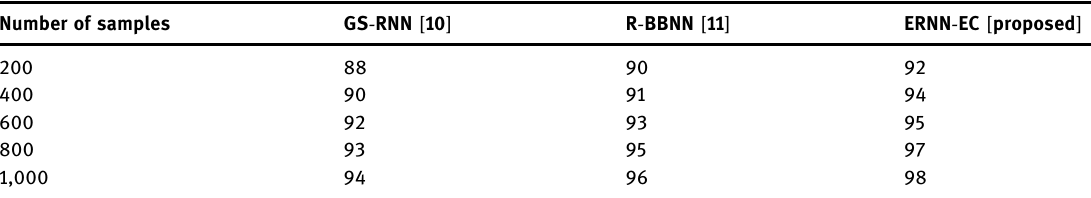
Table 3: Analysis of